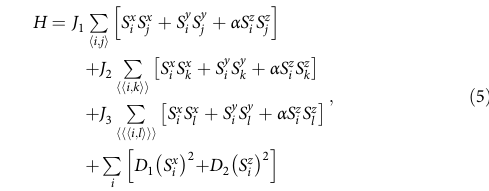
K. The 514.4-nm (2.41 eV) line of diode-pumped-solid-state (DPSS) laser was used as the excitation source. The laser power was kept below 100 μ W to avoid